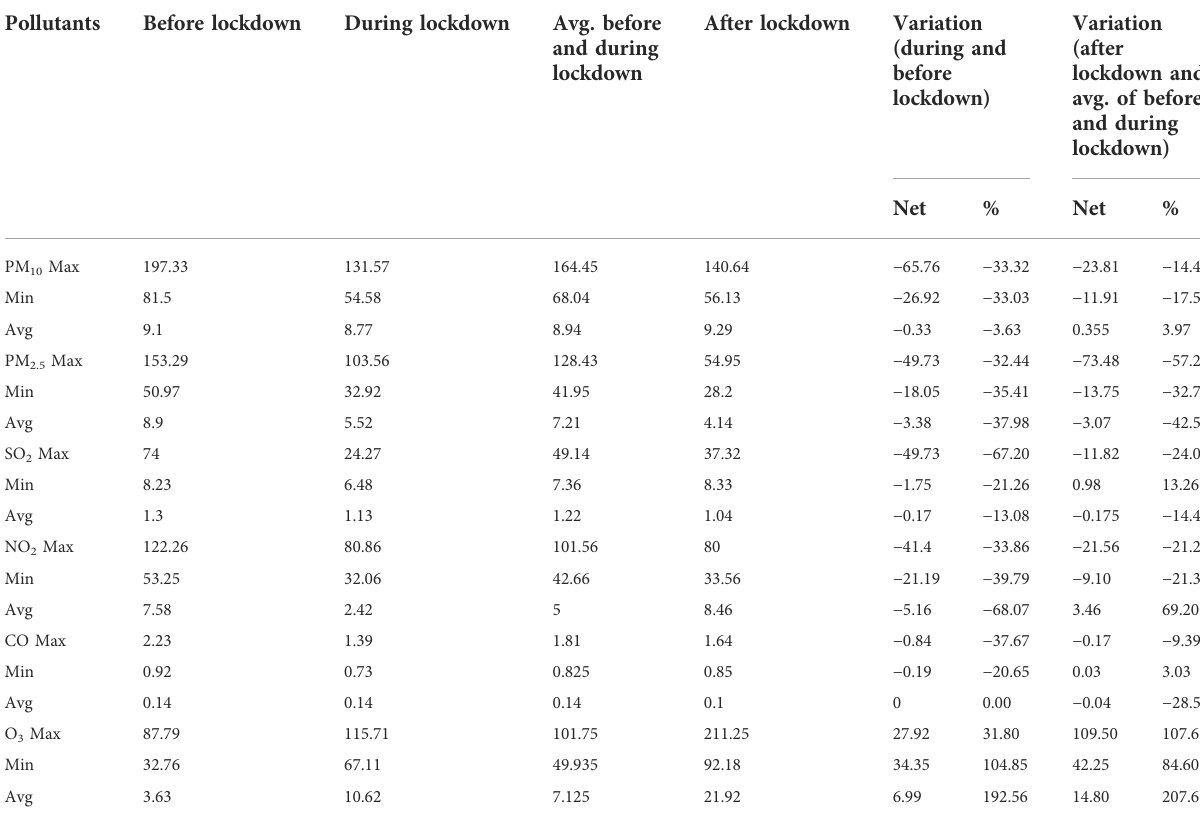
TABLE 1 Daily average concentration and variation of pollutants in different time periods in